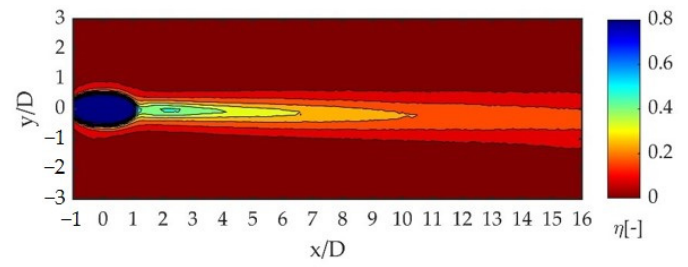
Figure 3. A sample of experimental data matrix.